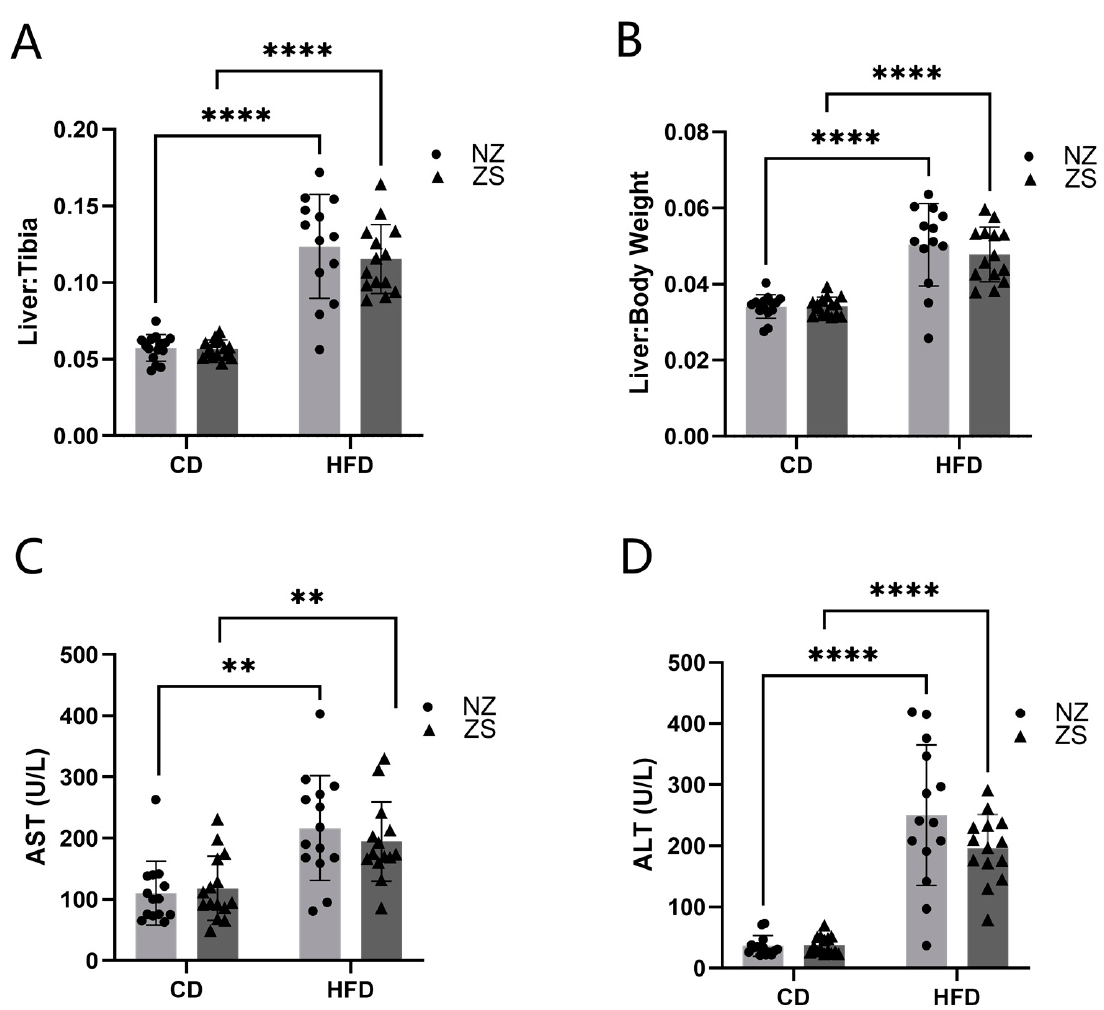
Figure 5. Effects of HFD and zinc supplementation on liver injury. HFD-induced liver injury was not reduced by zinc supplement. ( A , B ) Ratio of liver to tibia and body weight, measures of hepatomegaly. ( C ) Plasma aspartate aminotransferase (AST) and ( D ) alanine aminotransferase (ALT) activities were increased in HFD fed groups. Data are reported as mean ± SD (n = 14–15 mice/group) with significance set to 0.05. ** p < 0.05, **** p < 0.0001. CD = control diet, HFD = high fat diet, NZ = normal zinc, ZS = zinc